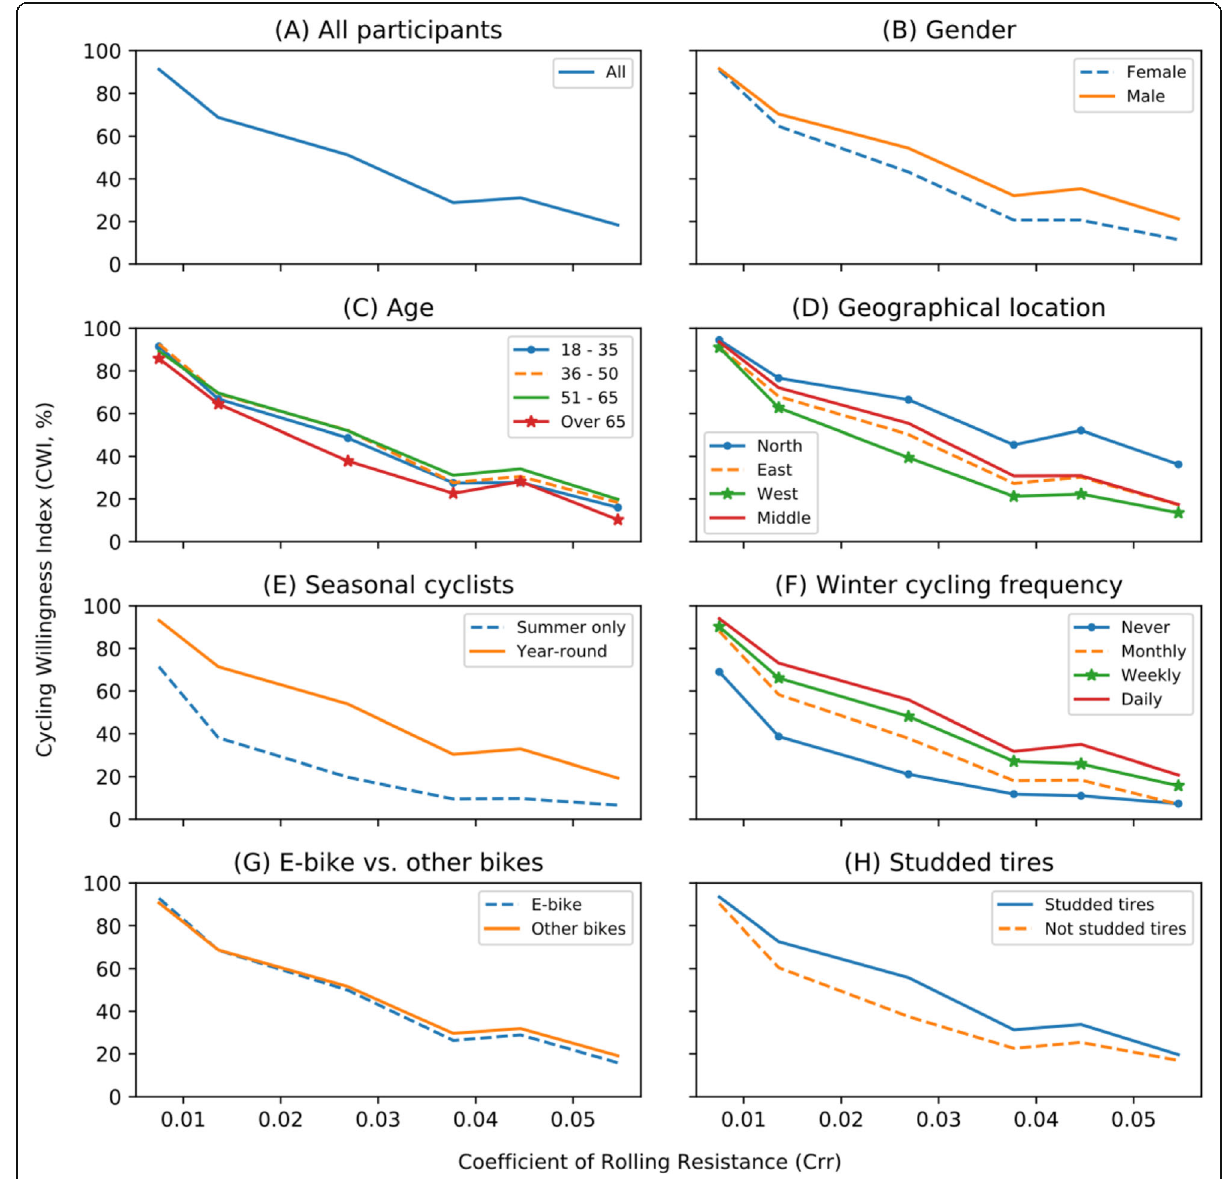
Fig. 2 Correlation between the cycling willingness index (CWI) and bicycle rolling